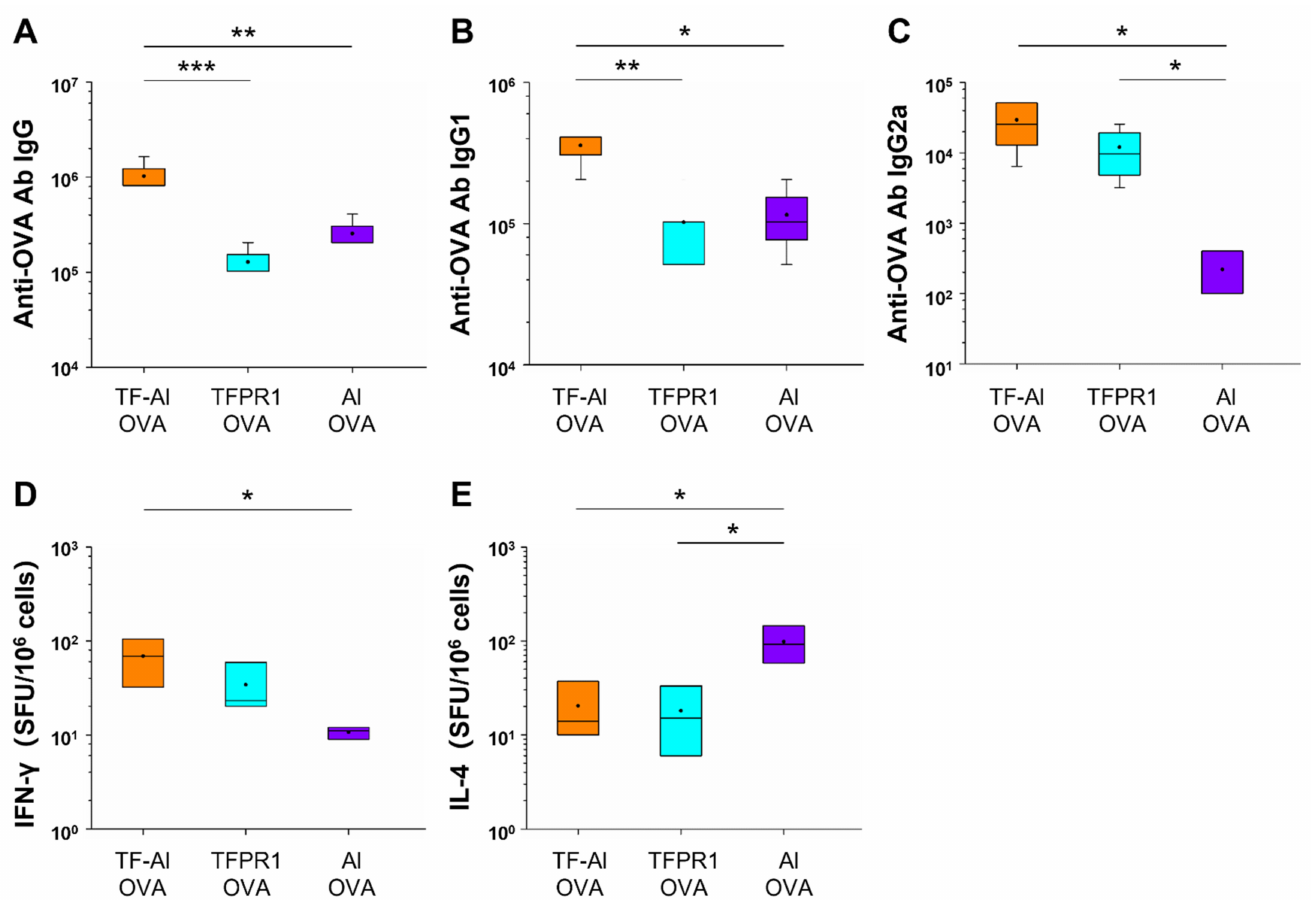
Figure 4. Detection of anti-OVA antibodies and cellular immune responses in C57BL/6 mice immunized with TF–Al and OVA. C57BL/6 mice were immunized thrice with TF–Al plus OVA, TFPR1 plus OVA or alum plus OVA intramuscularly. On the second week after the final immunization, anti-OVA antibodies were detected by ELISA and cellular immune responses by ELISPOT. ( A ) Anti-OVA antibody IgG. ( B ) Anti-OVA antibody IgG1. ( C ) Anti-OVA antibody IgG2a. ( D ) Specific IFN- γ . ( E ) Specific IL-4. Note: * stands for p < 0.05, ** p <